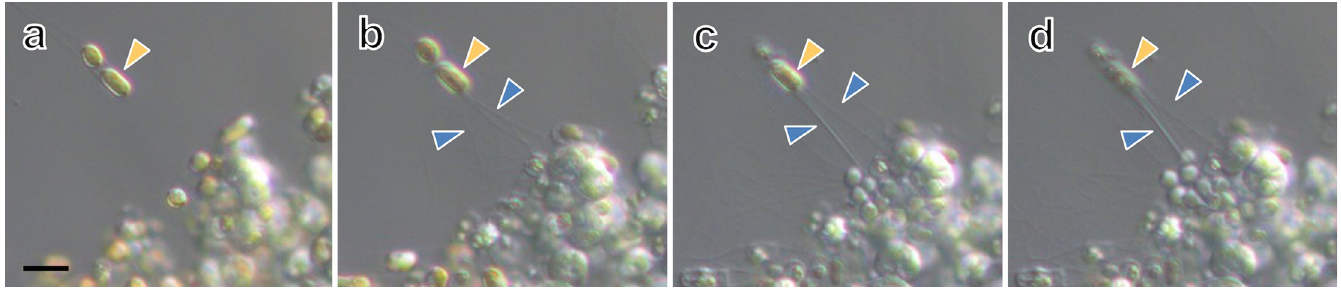
Fig 3. Continuous observation of nutritional intake from Skeletonema by Aplanochytrium cells via ectoplasmic nets. (a) Two-membered culture of Aplanochytrium (SEK 717) and Skeletonema (NIES 324). (b) Tip of ectoplasmic nets (blue arrowheads) of Aplanochytrium adhering to Skeletonema cells (orange arrowheads), 0 min. (c) Ectoplasmic nets increase in size and become more visible, 186 min. (d) In Skeletonema cell, chloroplast suddenly shrinks and changes color from yellow to white, 189 min. Scale bar = 10 μ m. These continuous observation images can be viewed as a time-lapse video movie (S3 Movie).